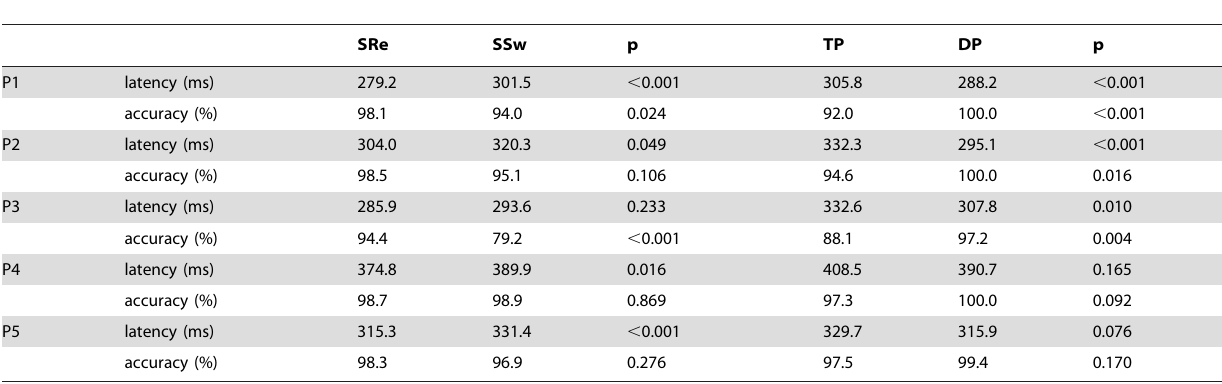
Table 1. The Mean Saccade Latency and Accuracy in Four Search Conditions in Each Subject.